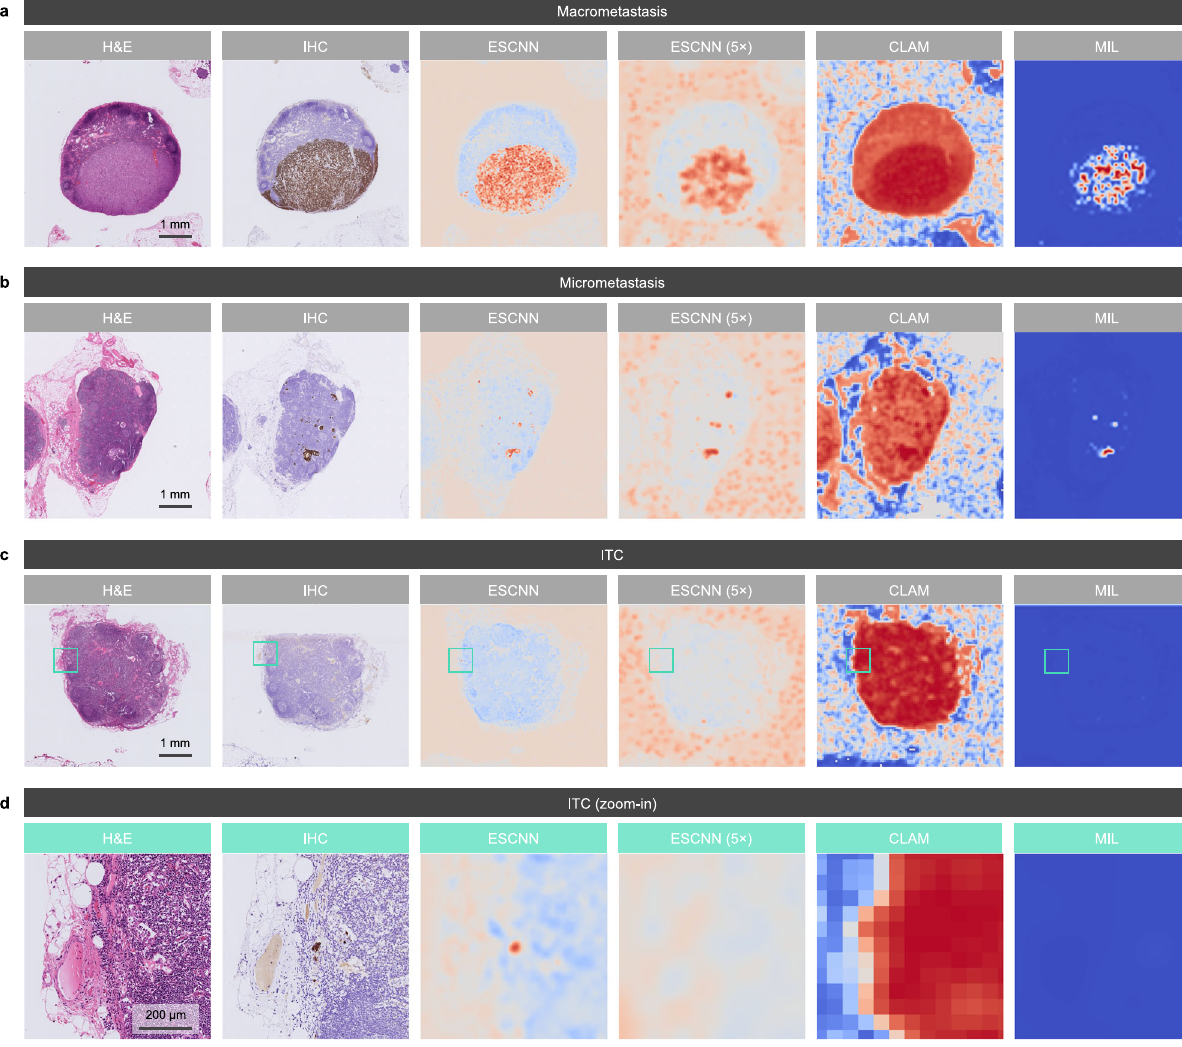
Fig. 4 Qualitative results of lesion highlights on macrometastasis, micrometastasis, and ITC cases. Each panel displays an example of an H&E-stained LN image, the reference standard of the metastatic area under IHC staining (cytokeratin AE1/AE3), the heat map for lesion localization generated by our model through CAM, the heat map generated by a 5× low-resolution ESCNN model, the attention map of a CLAM model, and the prediction map of a MIL model. Identi fi ed metastatic tumor cells are highlighted in brown and red in the IHC stains and heat maps, respectively. Examples of ( a ) macrometastasis, ( b ) micrometastasis, and ( c , d ) ITCs identi fi ed from the main test set demonstrated the high correspondence of the model-predicted area with the IHC- predicted area, where ( d) displays the high-power fi eld of the green boxes in ( c ). Aside from the displayed examples, the localization performance of our model remained at the same level for the 263 LN images from the main test set that were correctly classi fi ed as